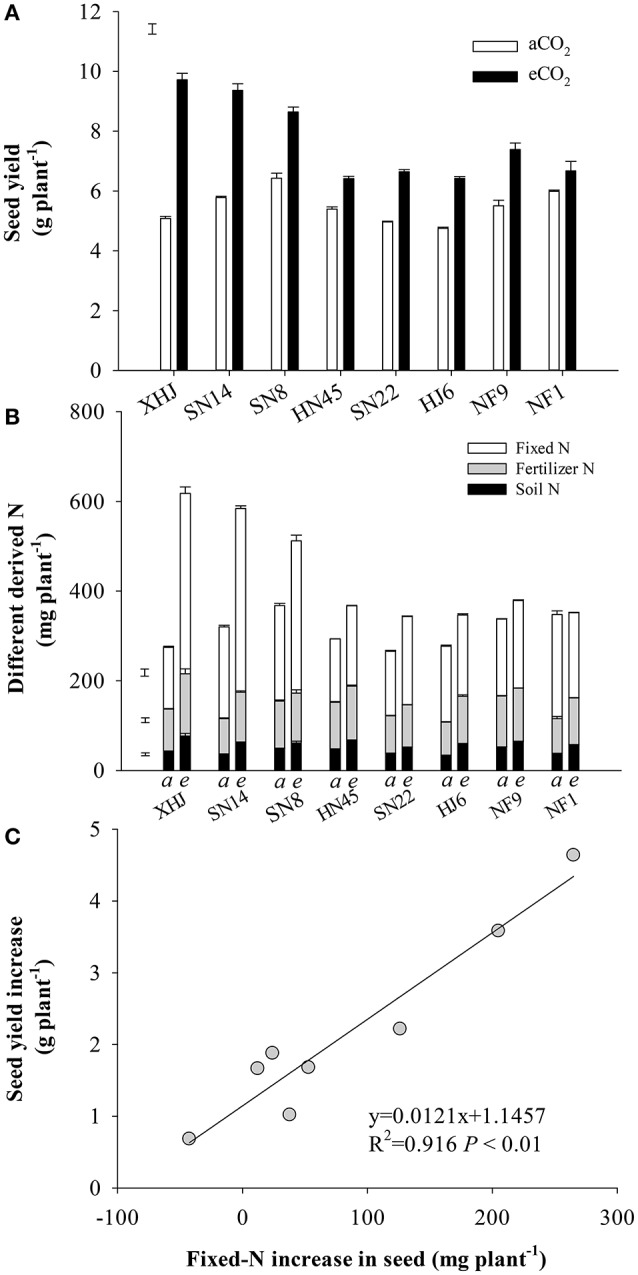
(A) Seed yield, (B) soil-derived N, fertilizer-derived N, and symbiotically fixed-N content in seed and (C) the relationship between increased fixed-N in seeds and yield increment of eight soybean cultivars under eCO2 relative to aCO2. Each data point represents one cultivar. The error bars represent standard error, and separate vertical bar(s) in (A) and (B) indicate the LSD (P < 0.05) for the CO2 × cultivar interaction.